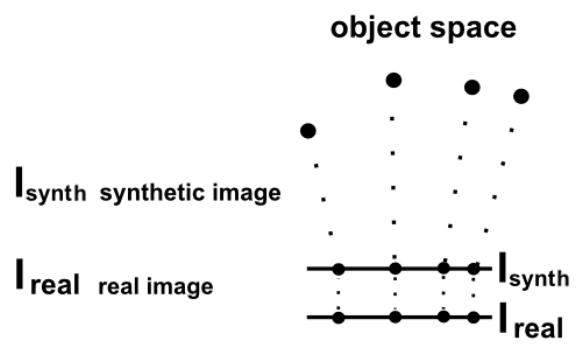
Figure 1: Schematic visualisation regarding the matching process of co-registered real and synthetic image